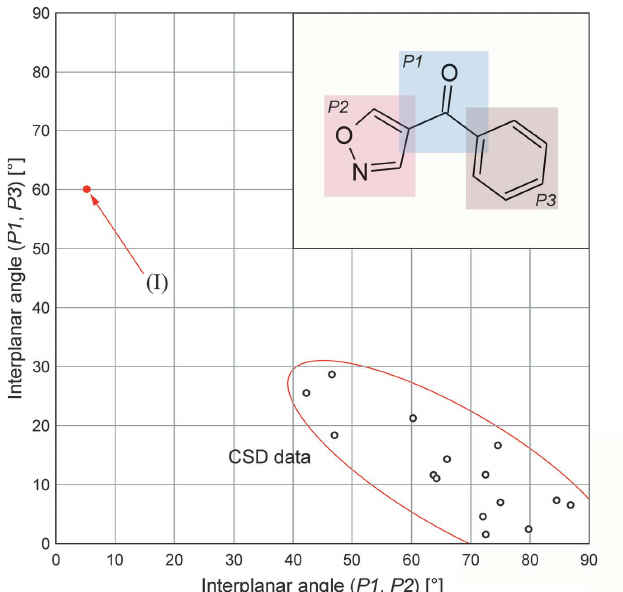
Figure 2 Plot of the interplanar angles ( P 1, P 3) against ( P 1, P 2), illustrating that the isoxaflutole molecule (red circle) has an unusual 1,2-oxazol-4- yl(phenyl)methanone conformation. Sixteen data points were obtained from 14 CSD structures (open circles) and isoxaflutole (filled red circle; see section 1 of the supporting information).